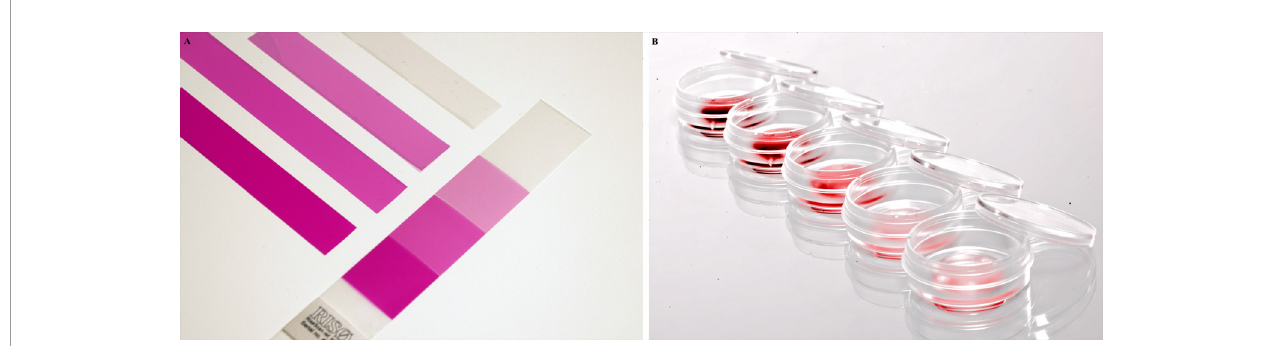
FIGURE 2 | Film and liquid dosimeter. (A) Risø B3 fi lm dosimeter. (B) TTC-based